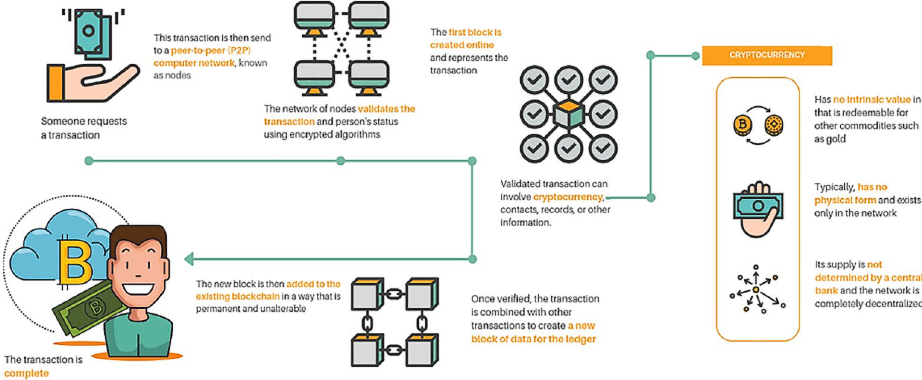
Figure 1. The data and transaction steps of